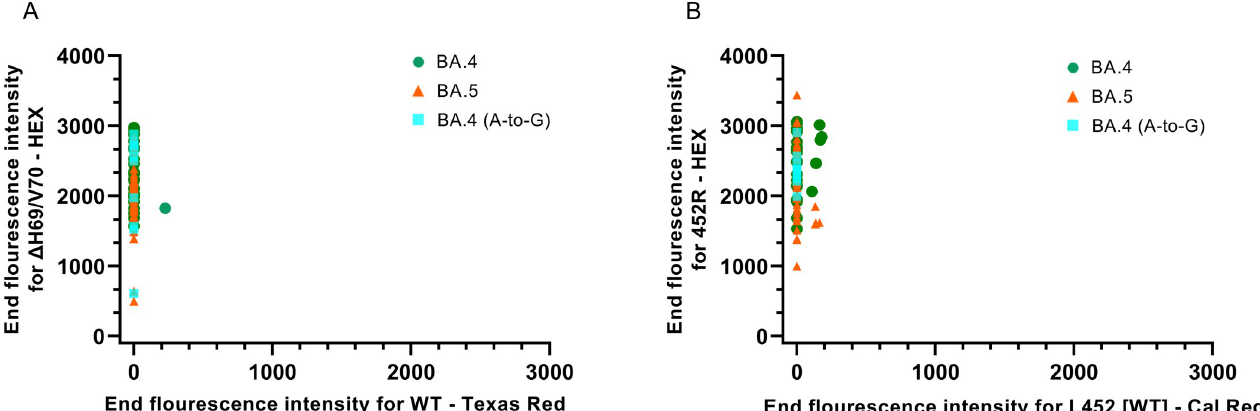
Fig 4. Detection of Δ H69/V70 and L452R mutations in BA.4 and BA.5. (A) Allelic discrimination analysis to differentiate between the Δ H69/V70 mutation and the WT sequence. (B) Allelic discrimination analysis to differentiate between the 452R mutation and the L452 WT sequence.